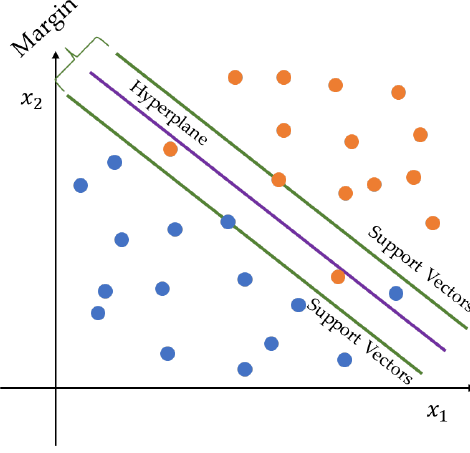
Figure 10. It shows the classification of